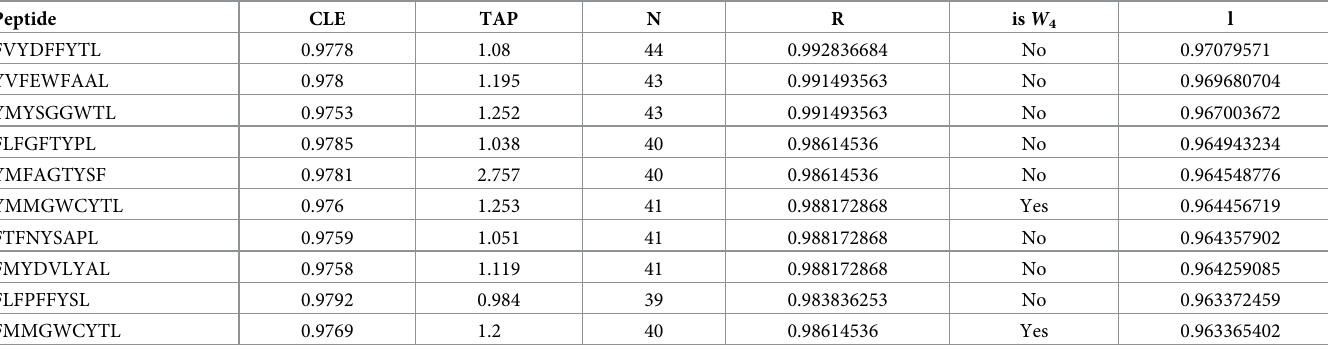
Table 5. Ranking of the most promising peptides for Trypanosoma cruzi. Peptide